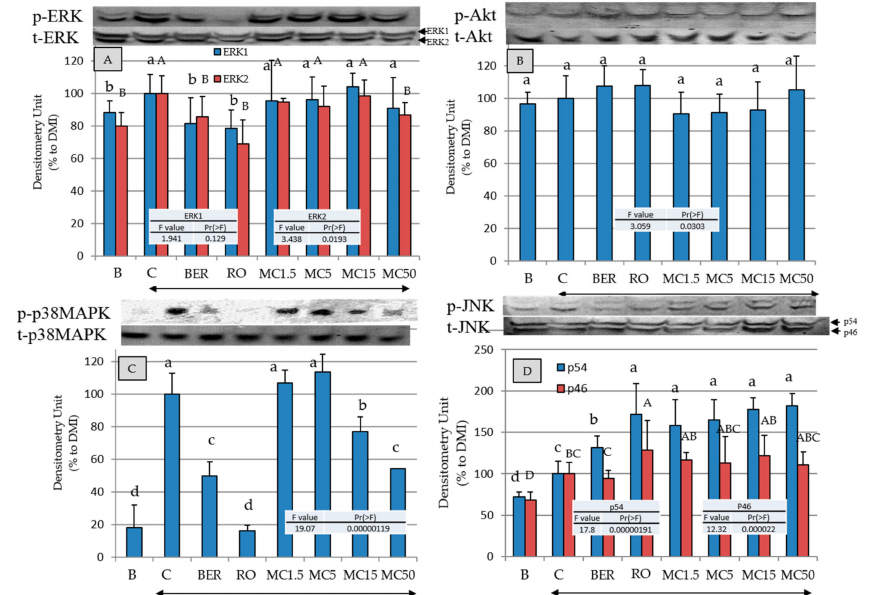
Figure 6. The e ff ects of each compound on the intracellular signal transduction-related protein levels in 3T3-L1 cells on day 8. Protein levels were measured by electroblotting. B (Black): Undi ff erentiated cells without the addition of the MDI, C (Control): cells with the addition of the MDI, BER: cells with MDI and berberine (2.7 nM), and RO: cells with MDI and rosiglitazone (100 nM). The number with MC indicate the concentration ( µ M). Arrows indicate the addition of the MDI mixture. Data are presented as the mean ± SD from three independent experiments. The same letters indicate that there are no di ff erences between those groups, and di ff erent letters indicate significant di ff erences ( P < 0.05).